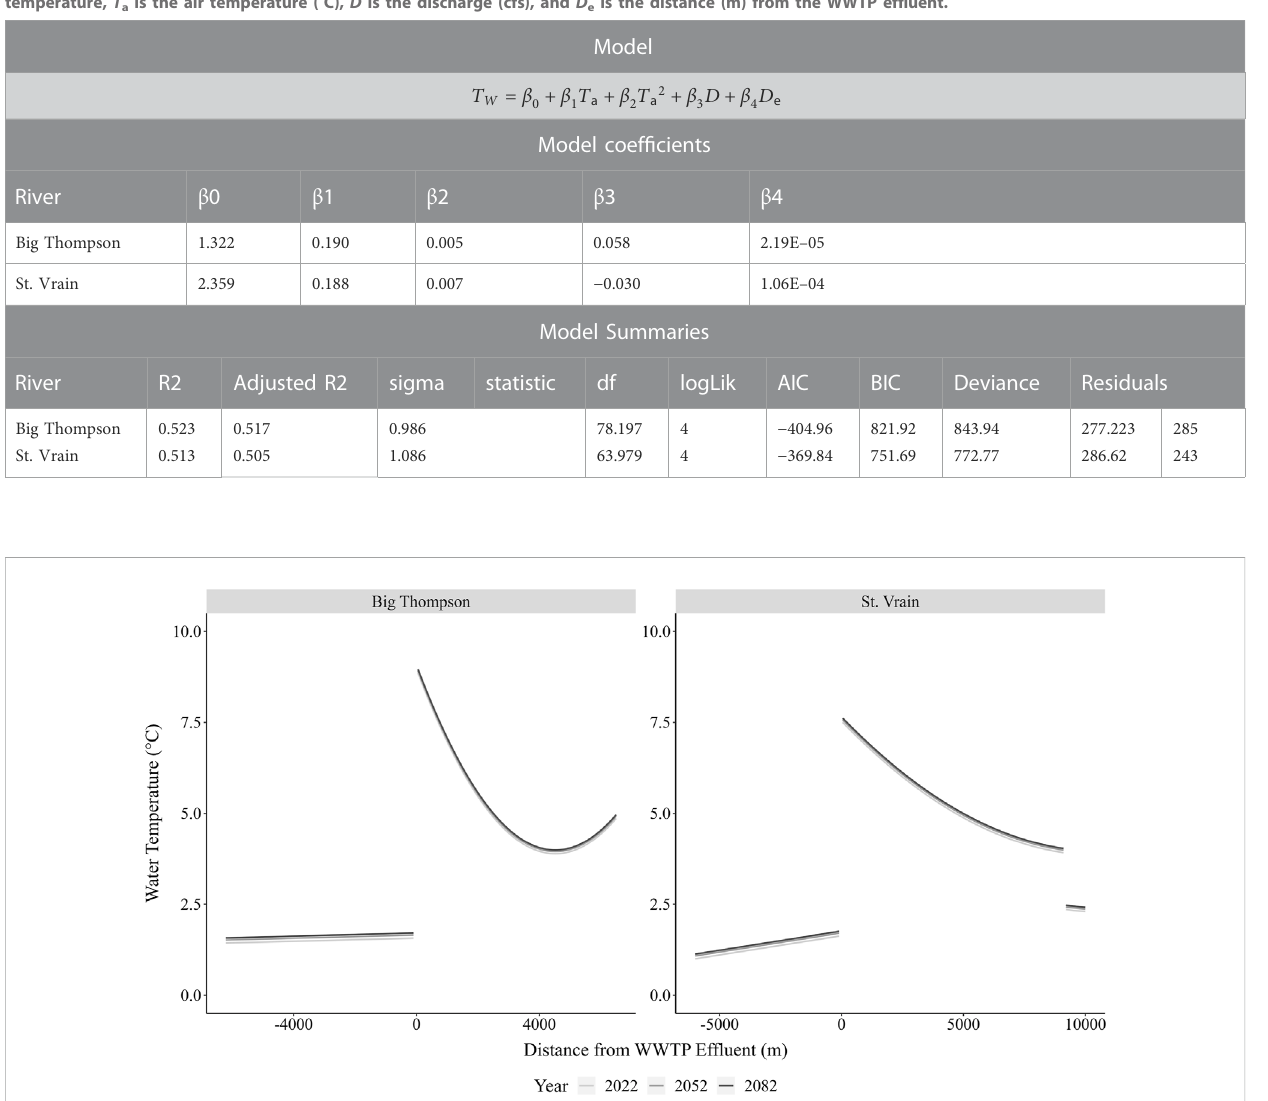
TABLE 2 Model coef fi cients and summaries for winter water temperature in the Big Thompson and St. Vrain upstream of the WWTP ef fl uent. All coef fi cients in the models, except for the distance from the WWTP ef fl uent coef fi cient ( β 4 ; in bold), were signi fi cant predictors of water temperature ( p < 0.05). T w is water temperature, T a is the air temperature ( ˚ C), D is the discharge (cfs), and D e is the distance (m) from the WWTP ef fl uent.